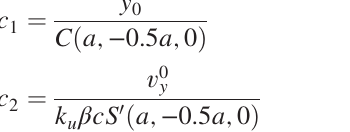
FIG. 2. Variation of magnetic field along y near the region of approximation k u y → 0 B z → k u y cos ð k u z Þ